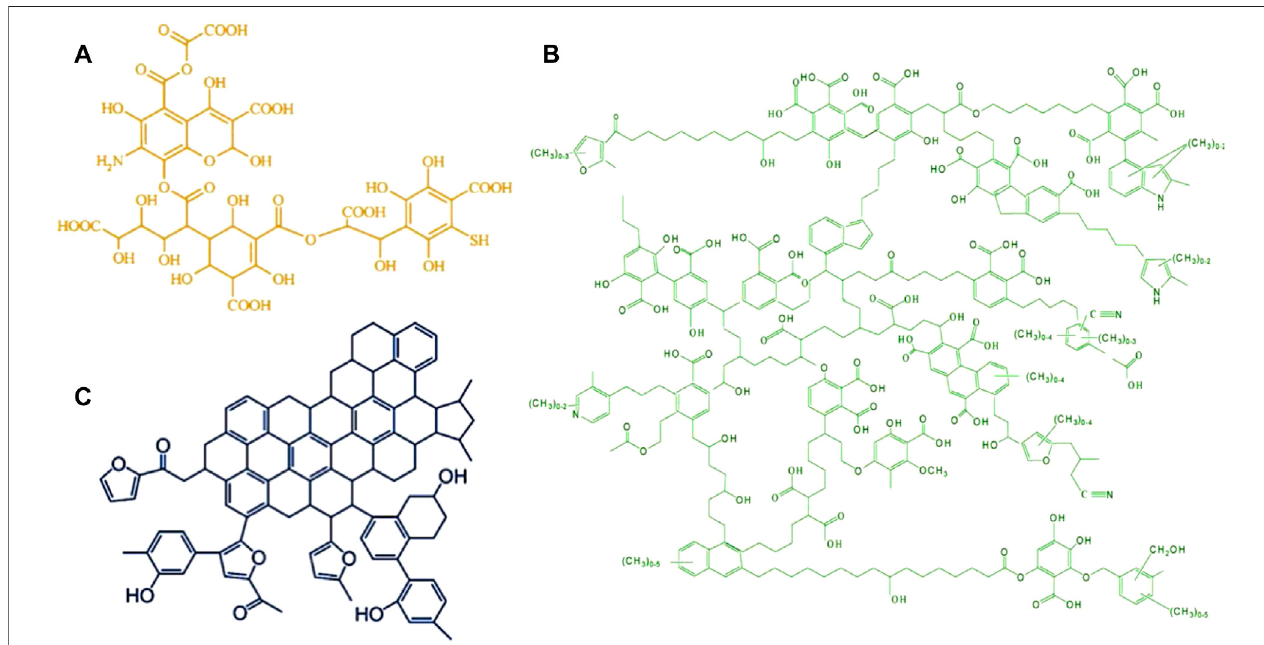
FIGURE 2 | Proposed structure models of fulvic acid (A) reproduced from the work by Alvarez-Puebla et al. (2006) with permission from Elsevier (copyright 2006), humic acid (B) reproduced from the work by Terkhi et al. (2008) with permission from Elsevier (copyright 2008), and humins (C) reproduced from the work by Chuntanapum and Matsumura (2009) with permission from ACS Publications (copyright